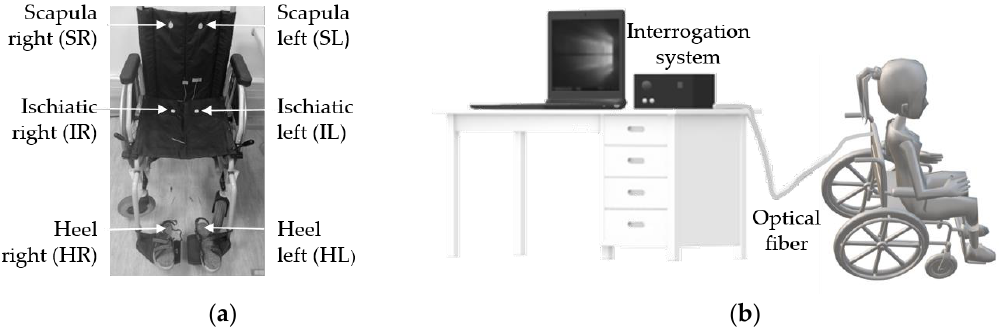
Figure 4. ( a ) Wheelchair with the six sensing cells; ( b ) Schematic representation of the experimental